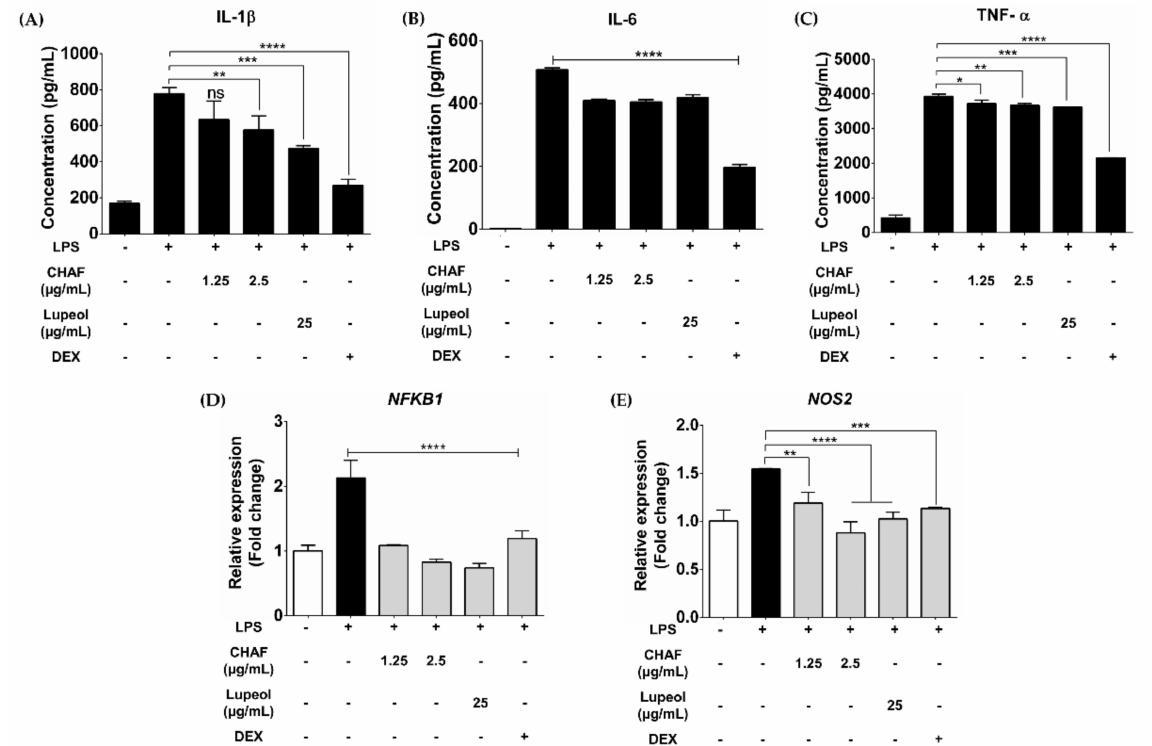
Figure 4. Anti-inflammatory effects of CHAF and lupeol in LPS-stimulated human MDMs. MDMs were pre-treated with CHAF and lupeol for 1 h, followed by treatment with LPS (100 ng/mL) for 12 h. Level of pro-inflammatory cytokines IL-1 β ( A ), IL-6 ( B ) and TNF- α ( C ). CHAF and lupeol were also affected by pro-inflammatory mRNA expression including NFKB1 ( D ), and NOS2 ( E ). Data are presented as mean ± SD. * p < 0.05; ** p < 0.01; *** p < 0.001; **** p < 0.0001 compared to